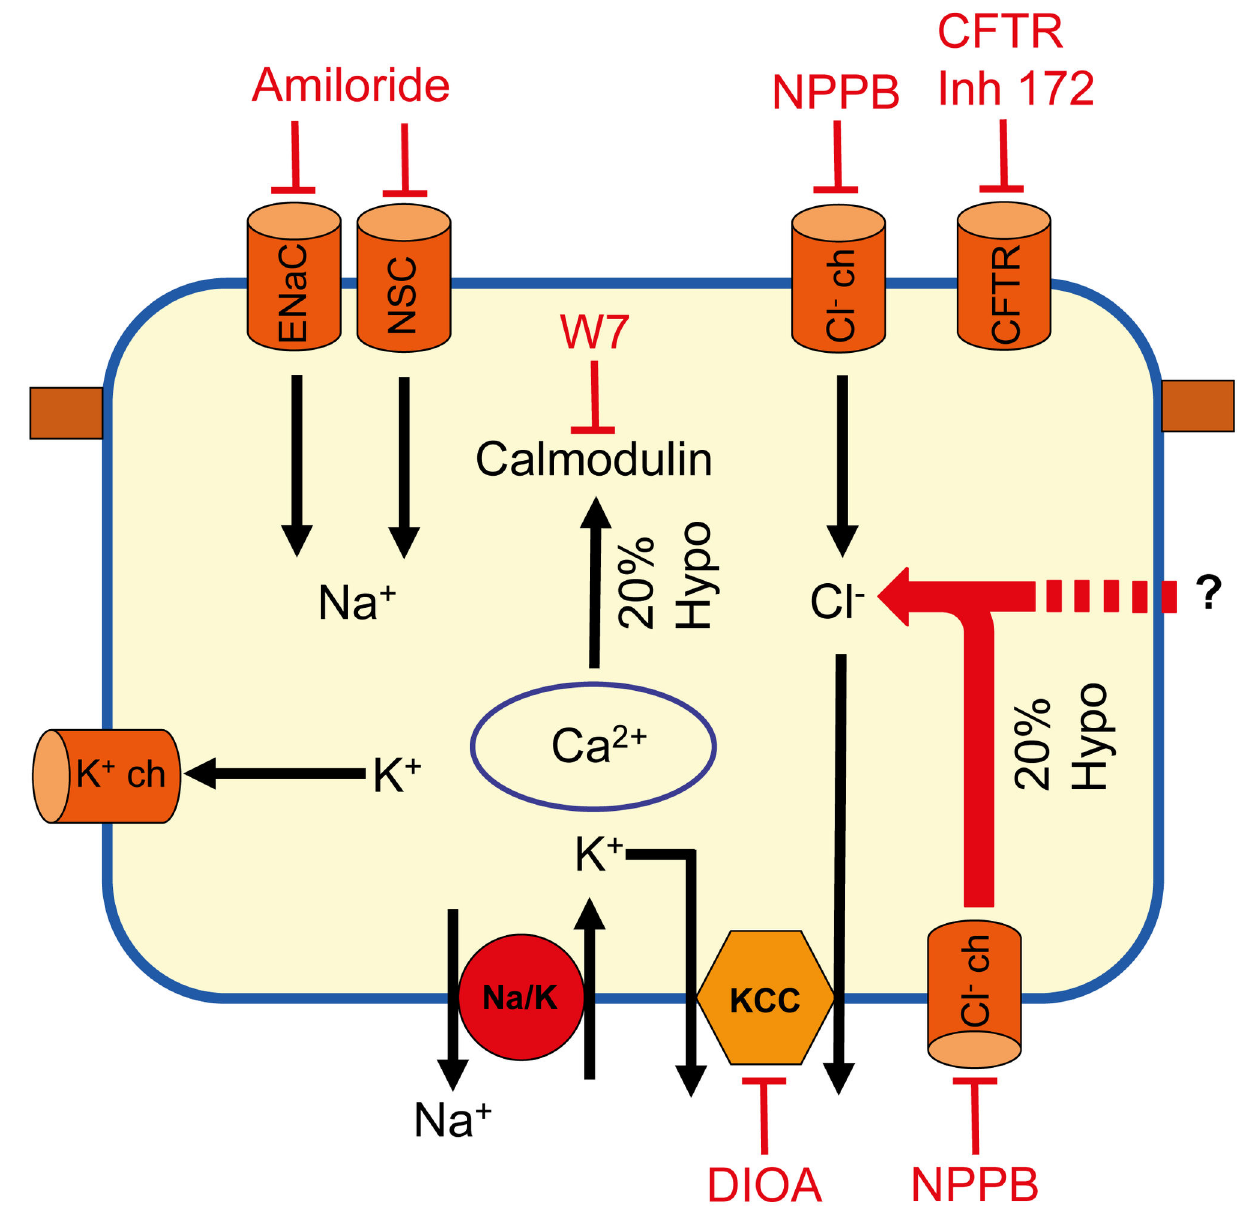
Figure 11. Channels and transporters involved in ionic transport in basal and hypotonic shock conditions. In the basal condition, a transcellular Cl - transport via NPPB-sensitive apical channels (Cl - ch) and basolateral K + /Cl - co-transporter (KCC) generates membrane potential that is optimal for Na + transport via amiloride-sensitive ENaC and NSC. Although alveolar epithelial cells express CFTR [59], in the absence of a cAMP agonist, CFTR is not involved in basal Na + transport. During a 20% hypotonic shock, Ca 2+ /calmodulin and a basolateral Cl - Influx play a central role in the transient current rise elicited by hypotonicity. NPPB- sensitive and insensitive pathways are involved for this flux. Although basolateral K + channels (K + ch) are not involved in the current rise elicited during hypotonic shock, their inhibition blunts current normalization after hypotonic shock. →: Ionic flux; T : Inhibitor.